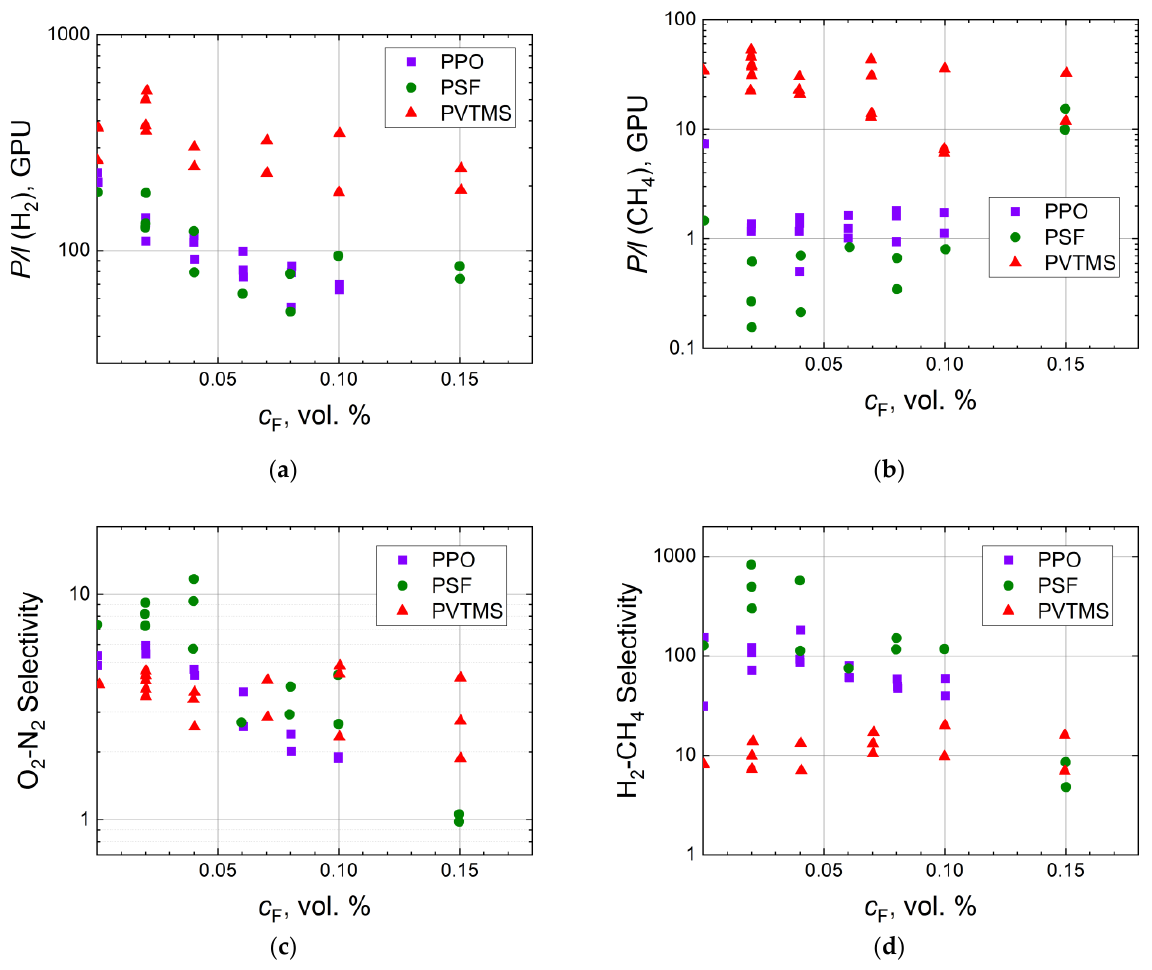
Figure 2. Dependence of H 2 ( a ) and CH 4 ( b ) permeances, ideal selectivities of O 2 -N 2 ( c ) and H 2 -CH 4 ( d ) for the virgin and fluorinated composite membranes (PPO [60], PSF [93], PVTMS [94]) on the content of fluorine in the fluorination mixture in semilogarithmic coordinates.